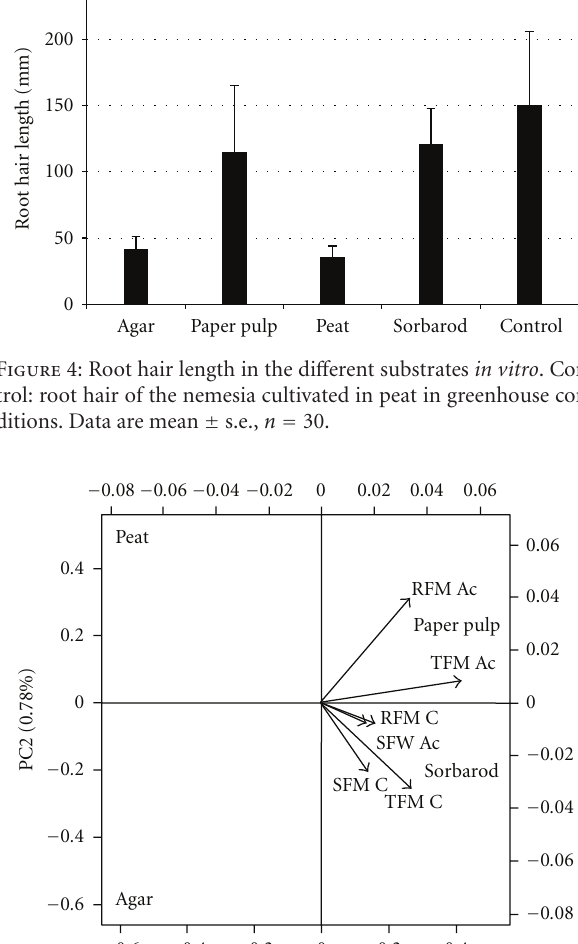
Table 2: Contribution percentage of each variable to discrimina- tion between the four substrates along PC1 and PC2 axis in the non- linear principal component analysis. RDM Ac: root dry mass of ac- climatized nemesia; RDM C: root dry mass of in vitro cultured nemesia; RFM Ac: root fresh mass of acclimatized nemesia; RFM